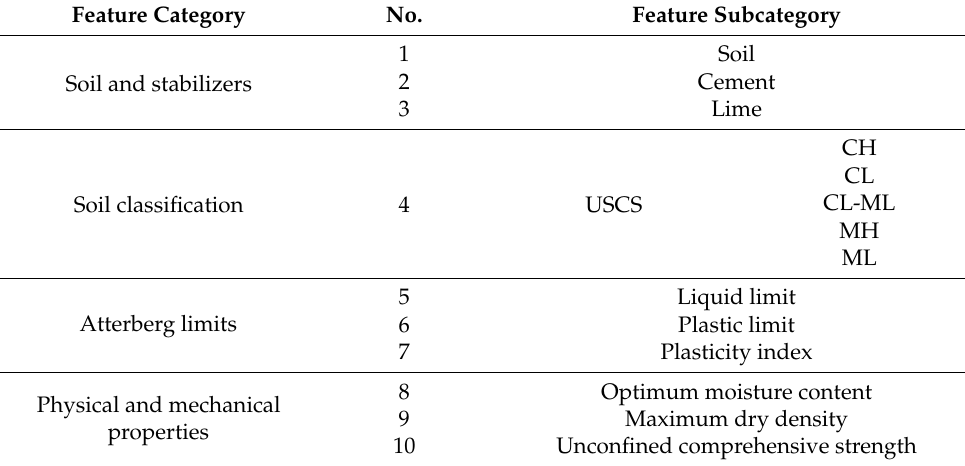
Table 1. Description of the features employed in the